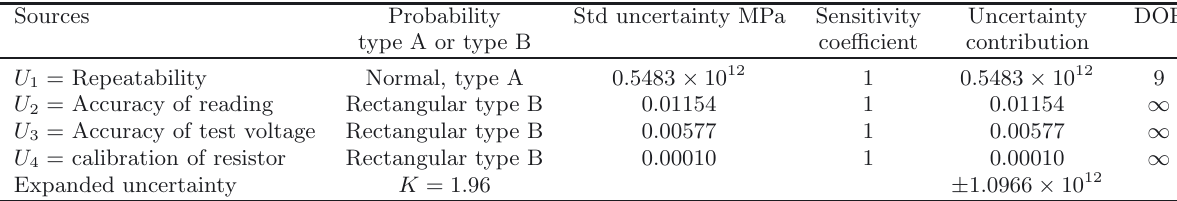
Table 7. Uncertainty budget.